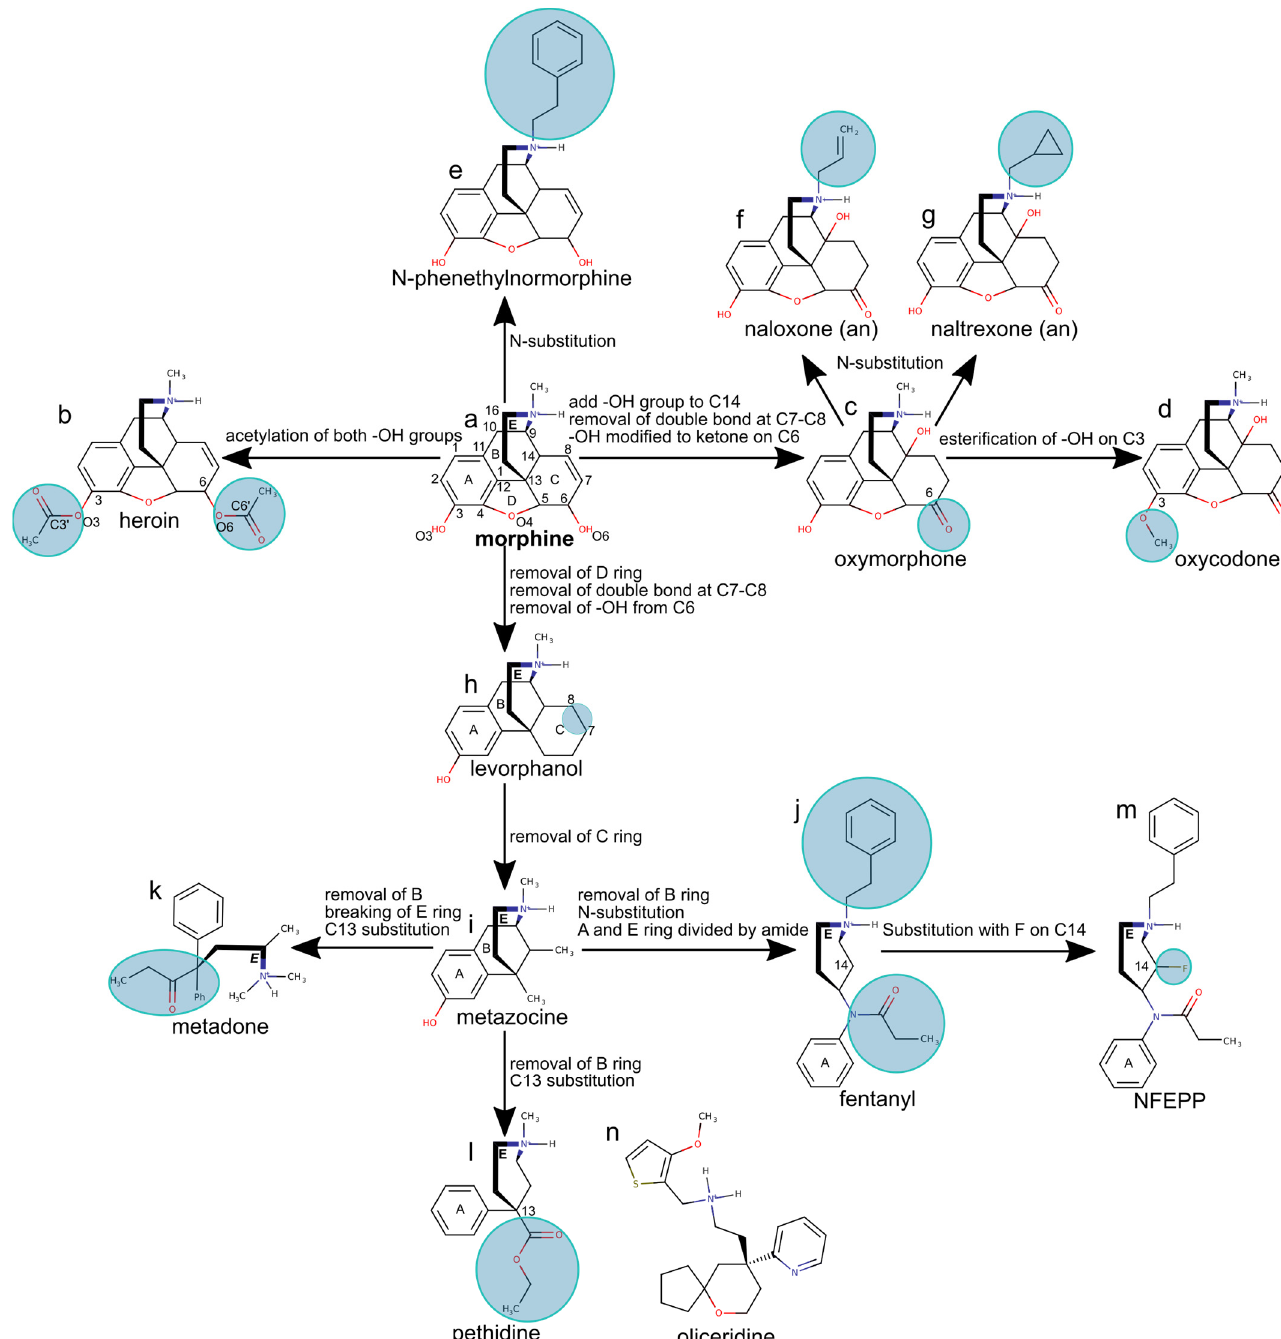
Figure 5. Design of selected morphine-based opioid compounds. We use the morphine molecule ( a ) to introduce the overall numbering and ring labels. In parantheses, “an” indicates an MOR antagonist; all other opioid drug molecules are agonists. Circles highlight the addition or substitution of moieties. The structure of ( b ) heroin, ( c ) oxymorphone, ( d ) oxycodone, ( e ) N-phenethylnormorphine, ( f ) the antagonist naloxone, ( g ) the antagonist naltrexone, ( h ) levorphanol, ( i ) metazocine, ( j ) fentanyl, ( k ) metadone, ( l ) pethidine, ( m ) NFEPP. ( n ) Oliceridine is an agonist unrelated to morphine. Chemical structures were drawn using MarvinSketch 19.4, developed by ChemAxon and assembled using Inkscape 1.0. Acetylation of the hydroxyl groups of morphine gives heroin (Figure 5b), an opioid drug more active than morphine, but with high addiction potential due to the fast onset of euphoria after intravenous injection. Once it passes the blood-brain barrier, heroin is metabolized to morphine, which then binds to MOR in the brain [59].